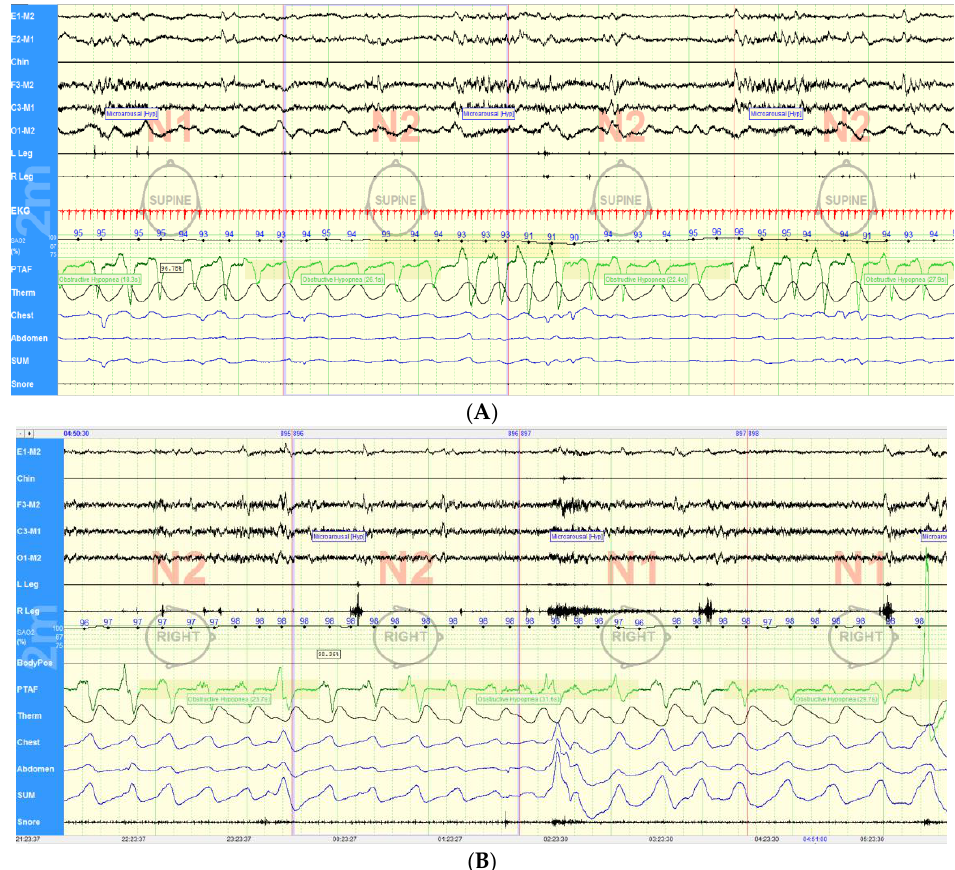
Figure 2. Patterns of upper airway obstruction in Parkinson’s disease. ( A ) Obstructive hypopneas associated with microarousals and oxygen desaturation in a patient with Parkinson’s disease and obstructive sleep apnea. ( B ) Upper airway instability in a patient with Parkinson’s disease resulting in obstructive breathing. PTAF, pressure transducer airflow and Therm, thermistance. Chest and abdomen refer to the respective position of the bands used to detect respiratory efforts and SUM correspond to the sum of the chest and abdominal bands’ signal.